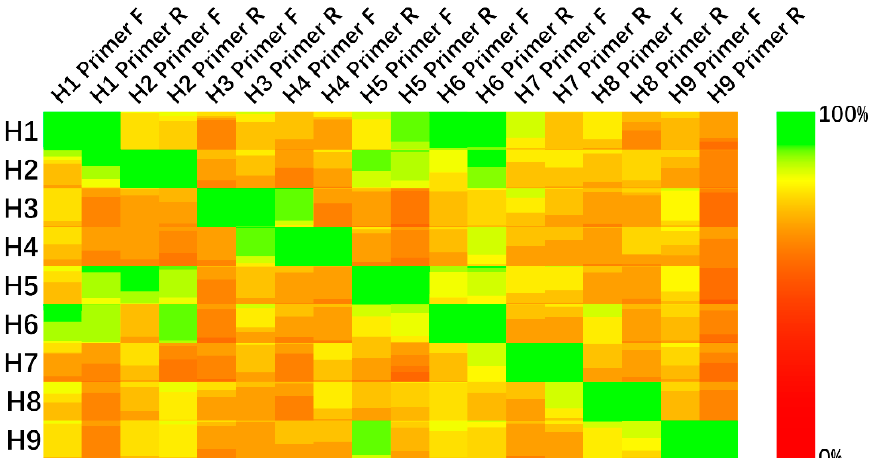
Figure 3. Matching of designed primers in H1–H9 subtypes. Each square contains 100 × 100 pixels, and each pixel inside the squares represents an equal proportion of samples. The HA subtype is labelled on the left of the figure; 100% base matching is expressed in green (RGB010); and 0% base matching is expressed in red (RGB100). Row names are labelled by HA subtype and column names are labelled by primer names.